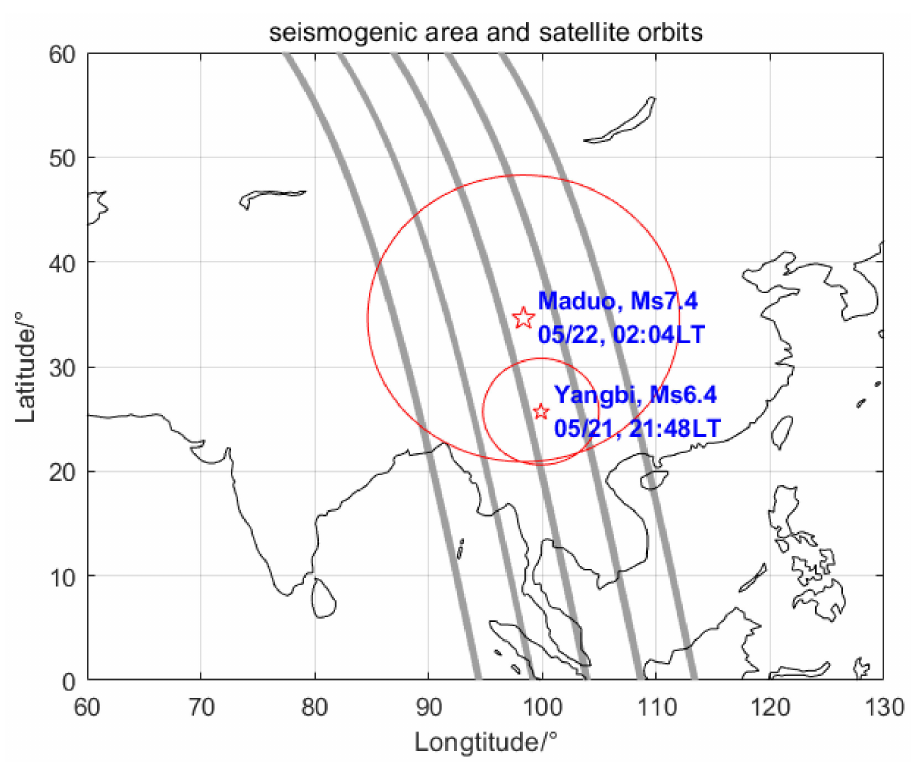
Figure 1. Epicenter, seismogenic zone and satellite revisit orbits. The gray lines are satellite revisit orbits (from south to north); the red stars and circles are epicenters and the seismogenic zones. Almost the entire seismogenic zone of the Yangbi earthquake is in the seismogenic zone of the Maduo